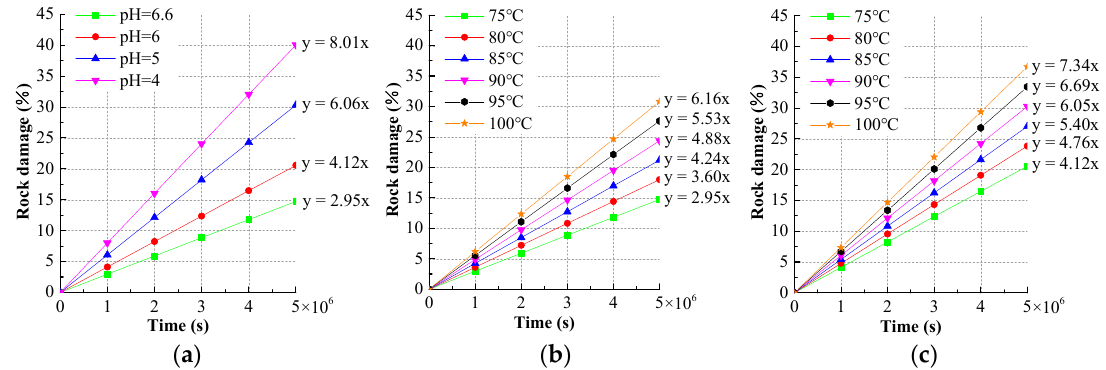
Figure 12. The rock damage change with time at di ff erent pH values and temperature ( k w = 2): ( a ) T = 75 ◦ C; ( b ) pH = 6.6; ( c ) pH = 6.